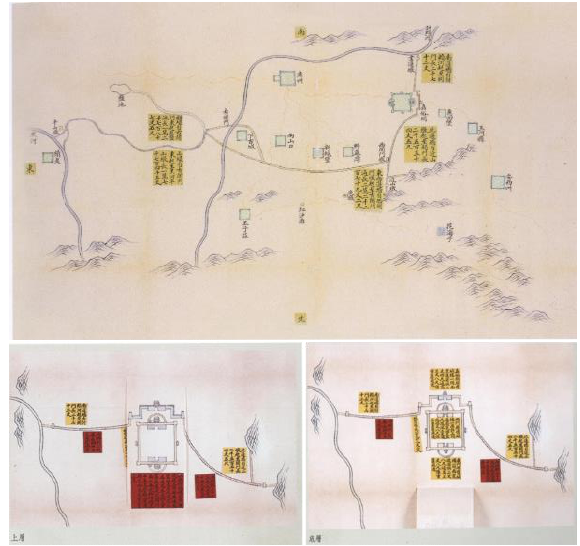
Figure.9 the two maps within the memorial to the emperor